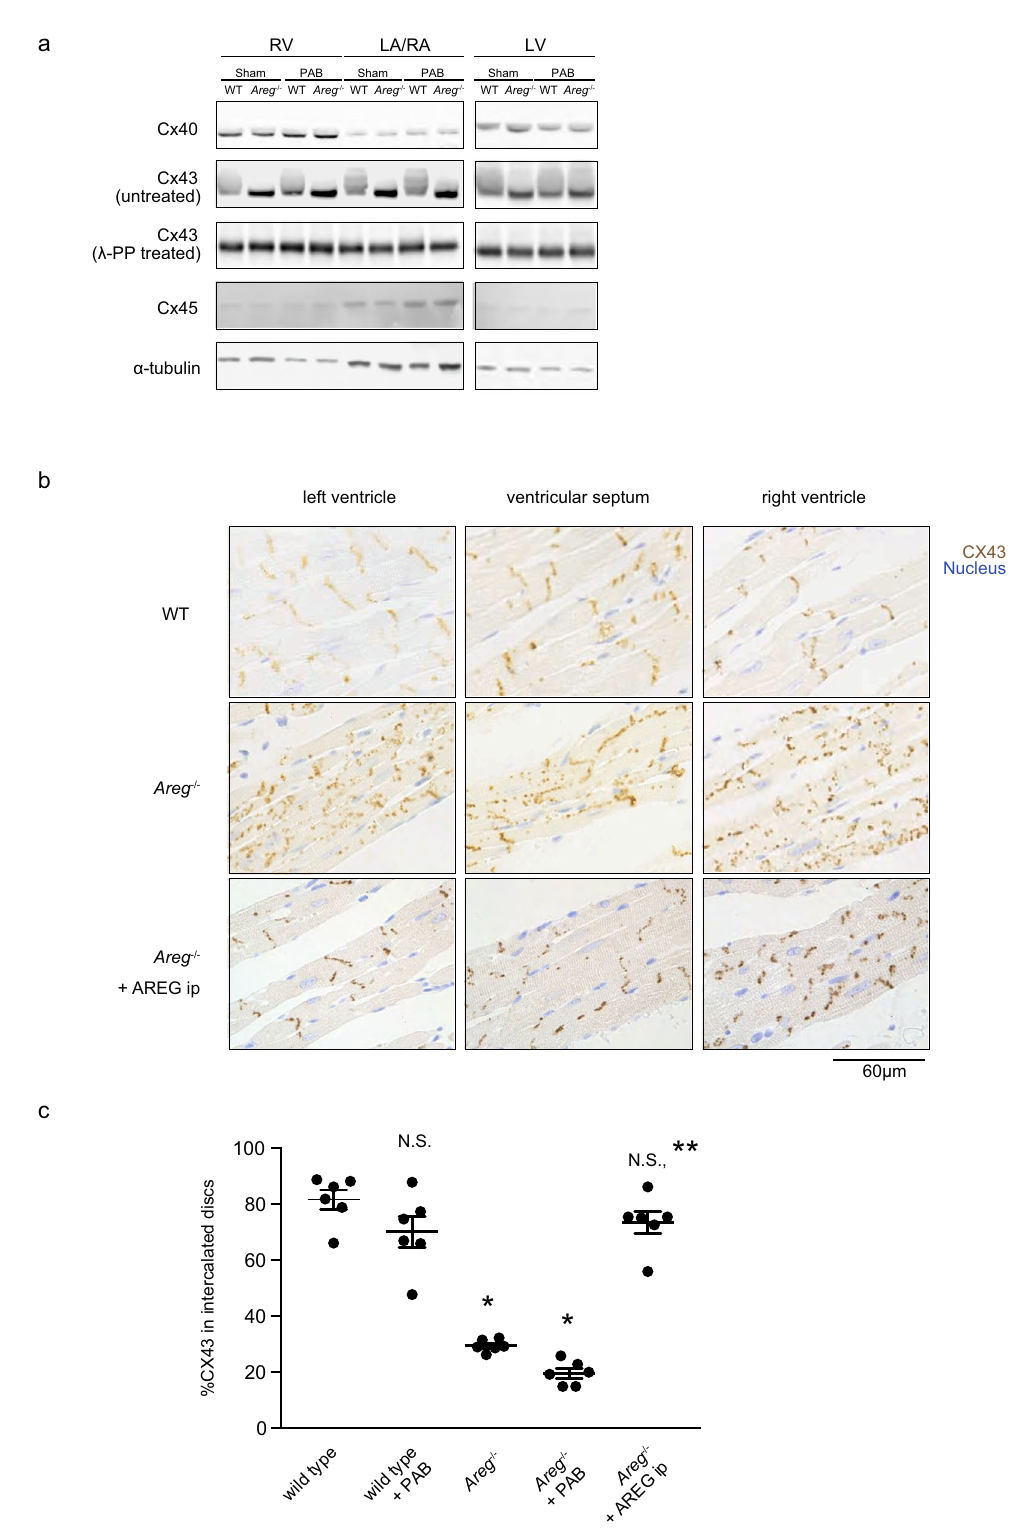
Fig. 3 AREG promotes gap junctional connection between cardiomyocytes through Cx43. a Western blot analysis of Cx40, Cx43, and Cx45. Representative immunoblots are shown. α -Tubulin was used as a loading control. Note the mobility shift of Cx43 bands in WT mouse hearts. b Immunohistochemical staining of Cx43 (brown) in the myocardium. Nuclei (blue) were counterstained with methylene blue. WT and Areg − / − mice were intraperitoneally administered either vehicle (PBS) or recombinant AREG (5 μ g), and the hearts were harvested 30min later. WT and Areg − / − mice not receiving AREG were administrated vehicle (PBS) 30min before sacri fi ce. The bar indicates 60 µ m. The images show representative immunohistochemically stained hearts from WT or Areg − / − mice at steady-state. c Fractions of Cx43 localized to the intercalated discs in cardiomyocytes in RVs. n = 6 mice in each group. One-way ANOVA followed by Tukey ’ s post-hoc test. * P <0.0001 vs. WT. ** P <0.0001 vs. Areg − / − . Data are presented as mean values ±